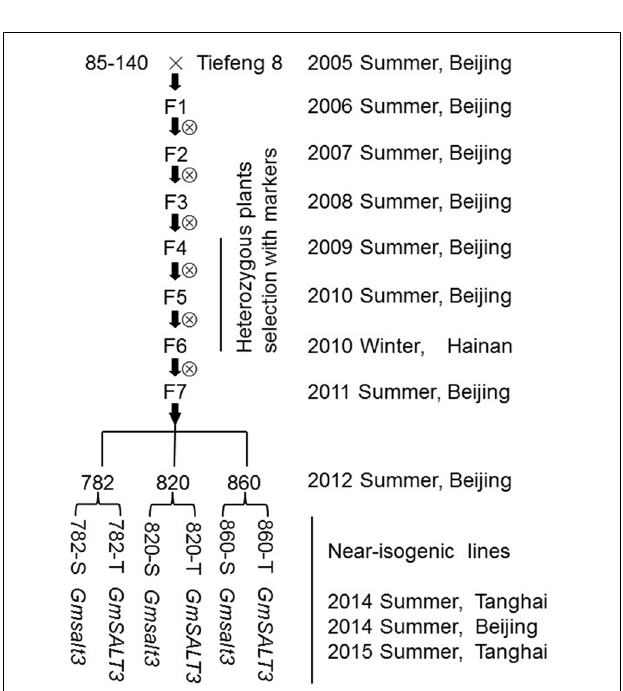
FIGURE 1 | Schematic diagram of the near isogenic lines (NILs) development by marker-assisted selection. Target region selection was employed from generation F 4 to F 6 . The NILs (782, 820, and 860) separated at the GmSALT3 locus were selected by using molecular markers from the progenies of three F 6 : 7